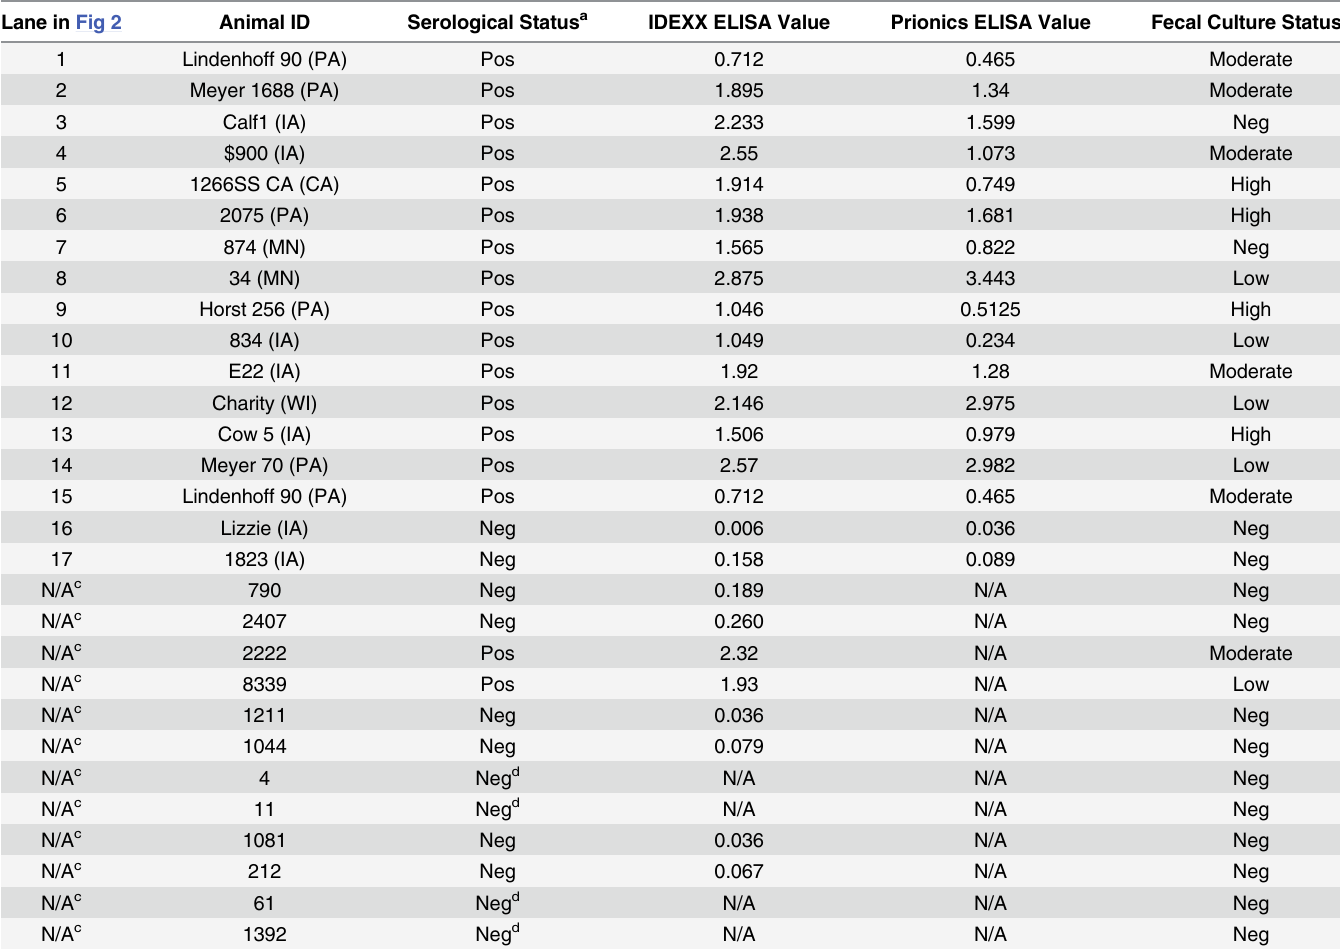
Table 1. Cattle Sera used in this